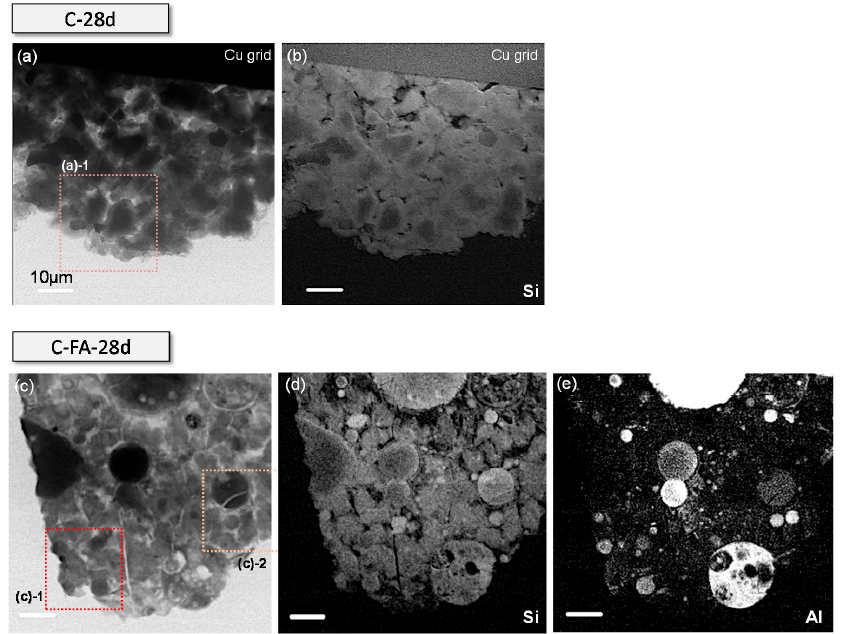
Figure 6. The STXM images of C-28d and C-FA-28d. ( a ) Single image of C-28d; ( b ) Si image contrast map of C-28d; ( c ) single image of C-FA-28d; ( d ) Si image contrast map of C-FA-28d; and ( e ) Al image contrast map of C-FA-28d. Single images were taken at 1840 eV. Image contrast maps were collected by subtracting the single image taken below each edge from above the edges. The brighter areas in the image contrast map ( b , d , e ) contains higher amounts of each element. The dotted square areas labeled with the index in ( a , c ) were magnified and used for NEXAFS analysis.